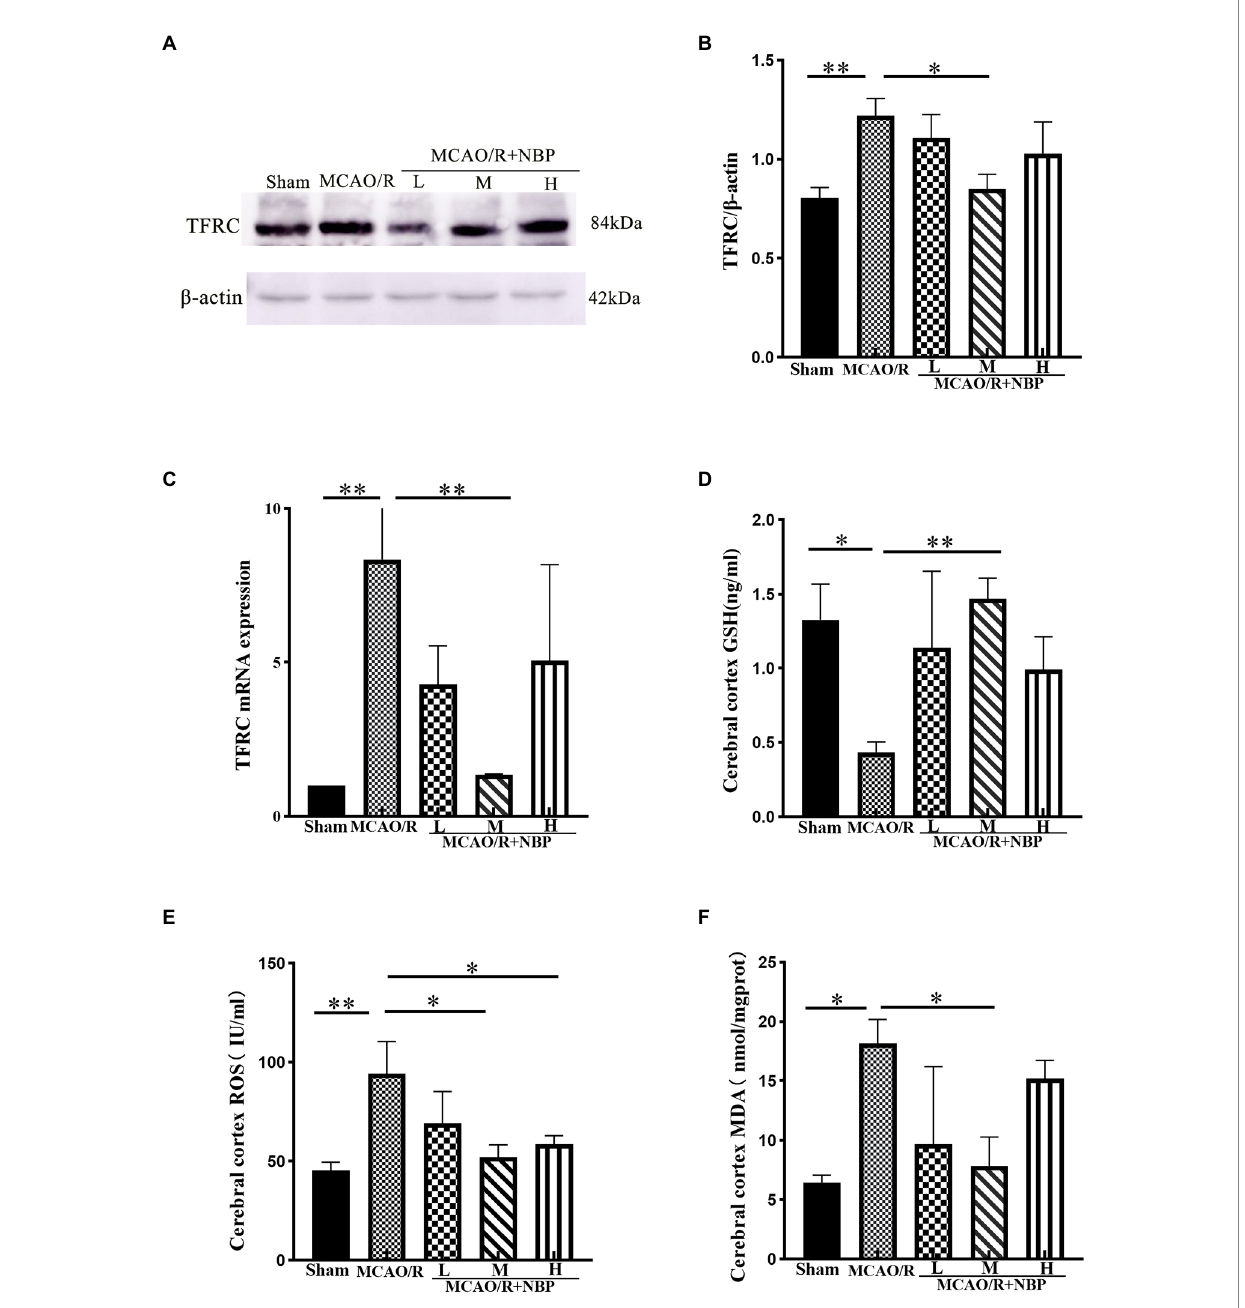
FIGURE 6 The relative levels of ferroptosis-related proteins were examined by Western blotting and ELISA. (A) Representative western blot image of TFRC. (B) Quantification of TFRC. (C) PCR for TFRC. (D–F) The result of GSH, ROS, and MDA by ELISA kit. ELISA, enzyme-linked immunoassay kit; TFRC, transferrin receptor; GSH, glutathione; ROS, Superoxide dismutase; MDA, malondialdehyde; PCR, real-time polymerase chain reaction. * p < 0.05, ** p < 0.01, *** p < 0.001. The values represent the mean ± SD, n =